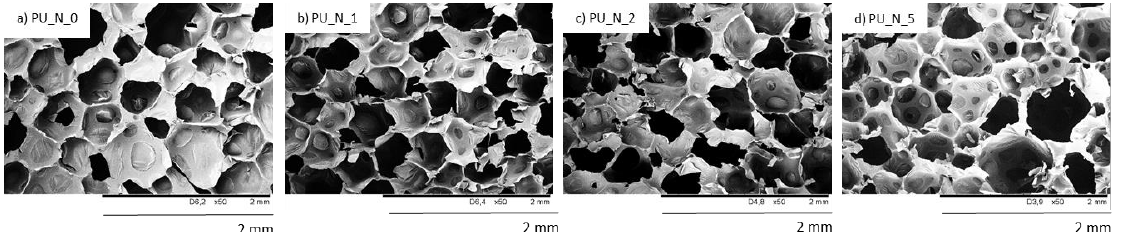
Figure 6. The cellular structure of ( a ) PU_N_0, ( b ) PU_N_1, ( c ) PU_N_2 and ( d ) PU_N_5 observed at a magnification of ×50. Adapted from Ref. [10].